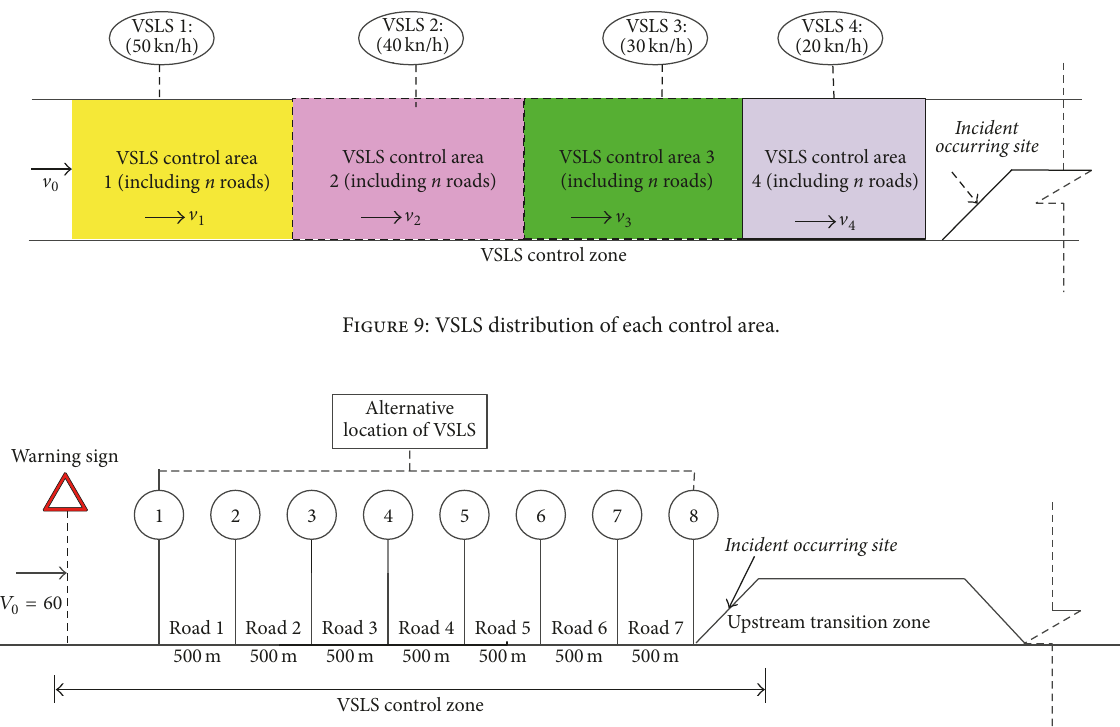
Figure 10: Simulation network of freeway work